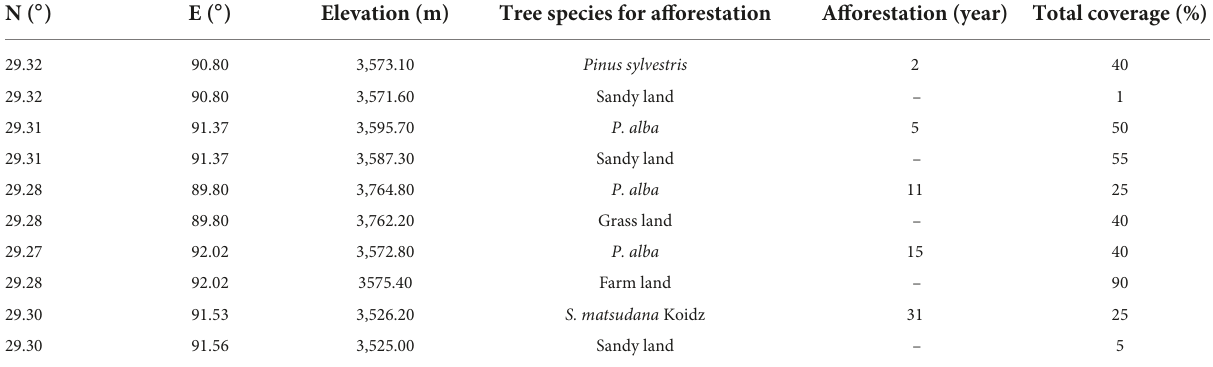
TABLE 1 Basic situation of the soil sample collection site.